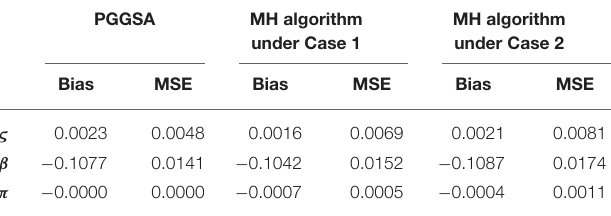
TABLE 3 | Evaluating accuracy of parameter estimation using the two algorithms in the simulation study 2. PGGSA